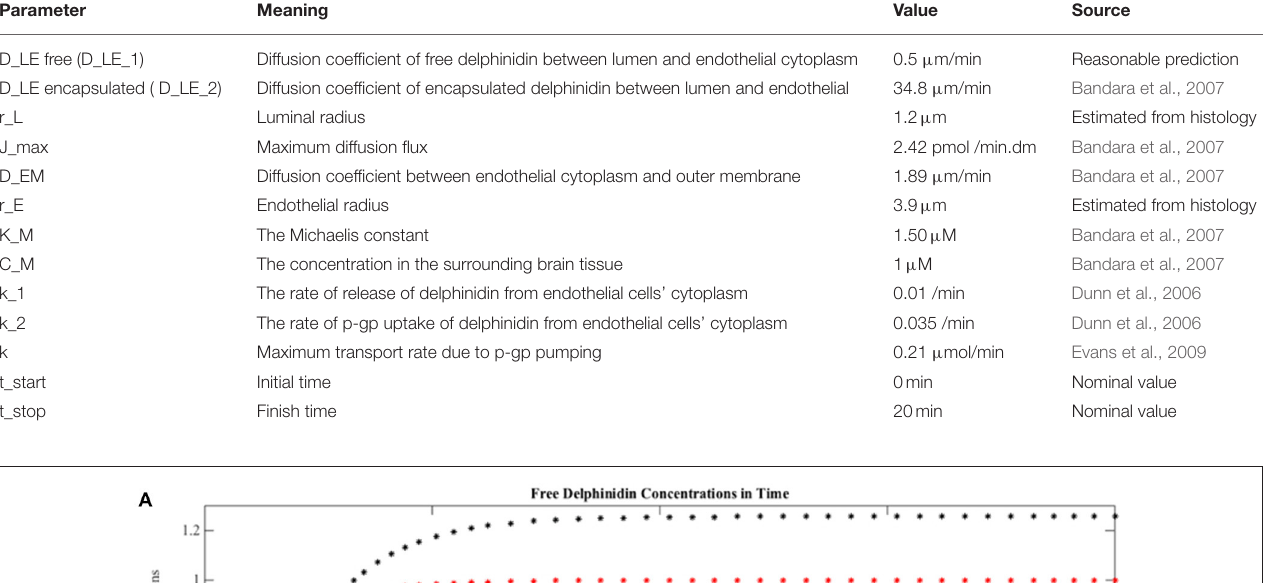
TABLE 3 | Model parameters and their meaning with known and estimated values where applicable. Parameter Meaning